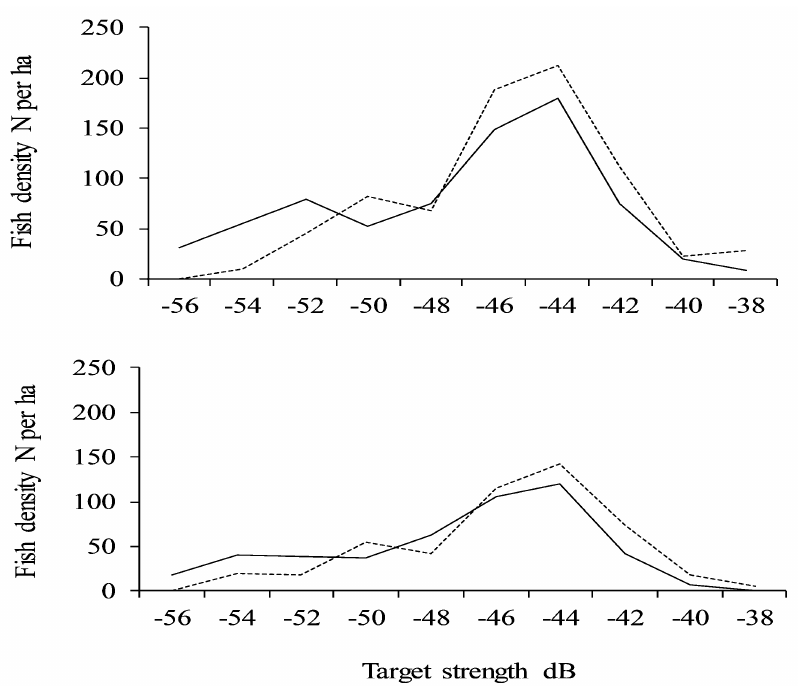
Figure 3. ( above ): Estimated means of total fish density of 10 transects based on Simrad EK15 (solid line) and Simrad EY-M (dotted line) at depth interval 18–32 m and ( below ): interval 32–48 m run simultaneously in May 2016.